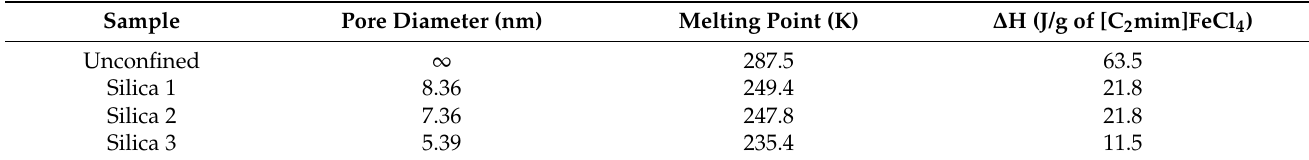
Table 2. Melting points and enthalpies of fusion for unconfined and confined [C 2 mim]FeCl 4 .